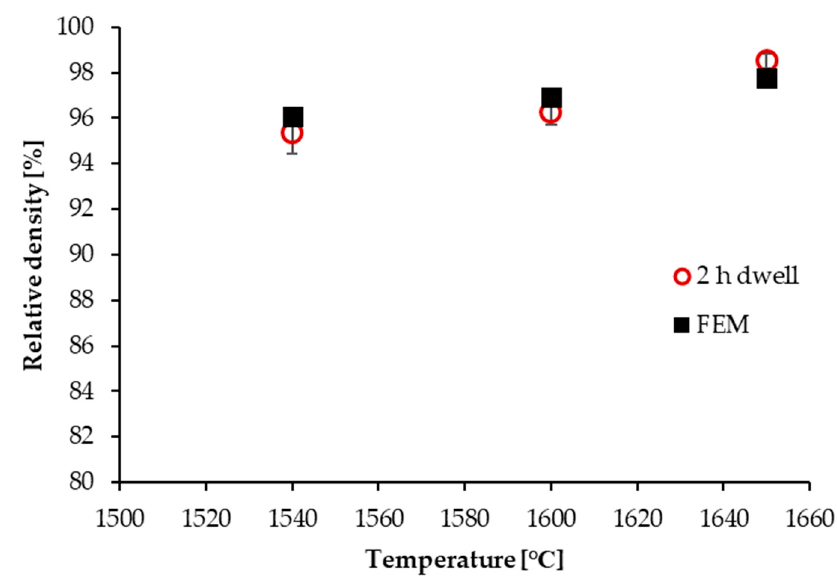
Figure 13. Experimental relative density vs. FEM predictions.